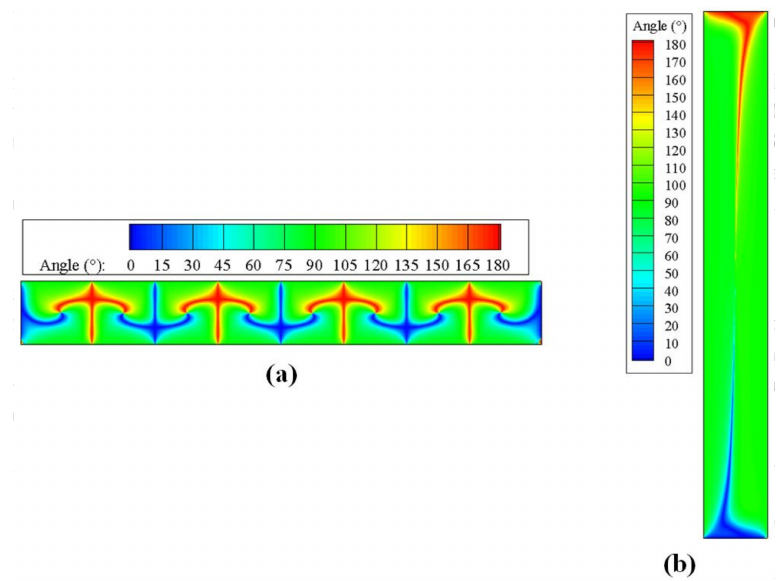
Figure 12. Intersection angle fields of the horizontal and vertical enclosures at L = 1000 mm, H = 130 mm, ∆ T = 40 K: ( a ) horizontal enclosure; ( b ) vertical